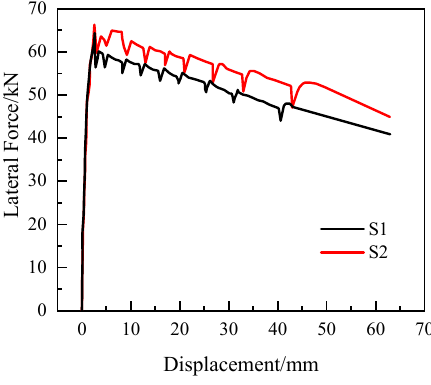
Figure 8. Load–deflection curves.